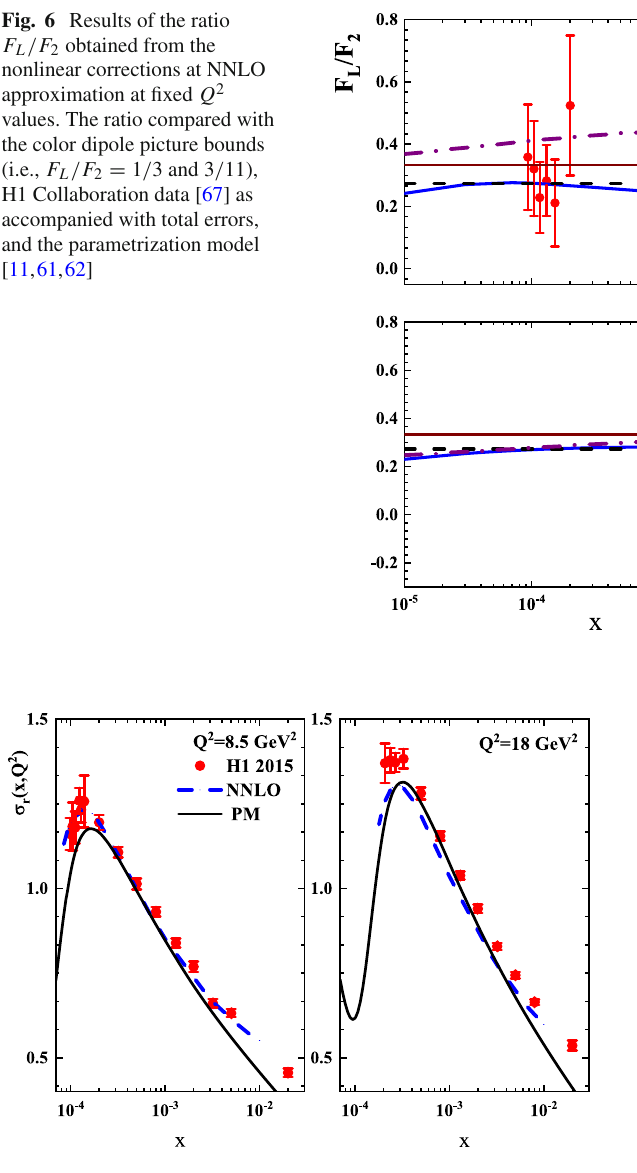
Fig. 7 The NNLO predictions for the reduced DIS cross section at Q 2 = 8 . 5 and 18 GeV 2 available. The H1 data for some representa- tive fixed values of Q 2 are taken from [66] as accompanied with total errors. The nonlinear corrections of the reduced cross section at NNLO approximation compared with the parametrization model